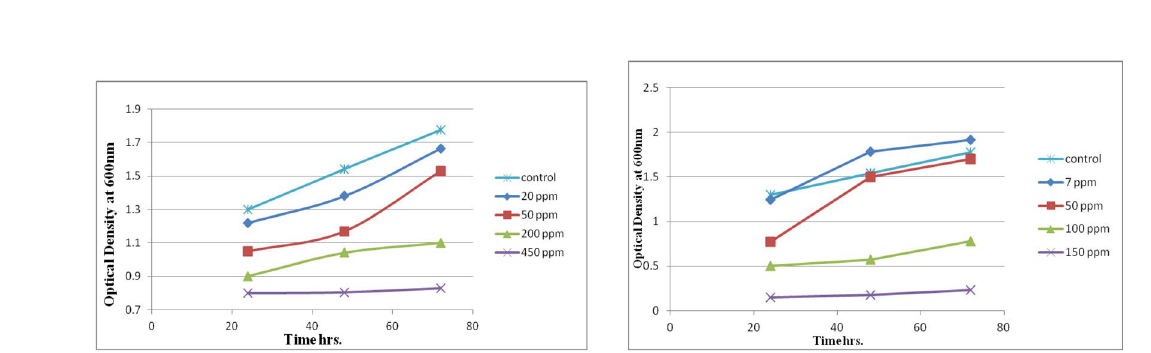
Fig. 9. Growth curve of isolate ST with (CdCl ) at 3 2 concentrations.